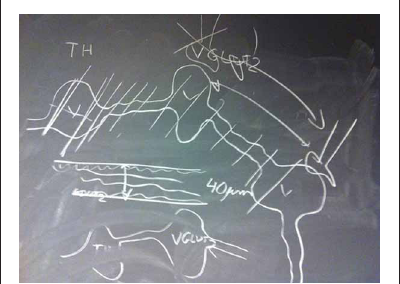
Figure 1 | Schematic diagram hand drawn by Laurent Descarries in December 2011, illustrating the formation of non-synaptic axonterminalsbydopamineneurons. Credit: Åsa Wallén-Mackenzie, Uppsala